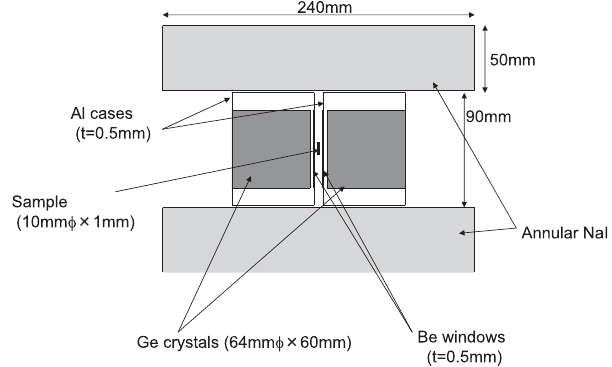
FIG. 2. A schematic view of a low-background (cid:1) detection system with two Ge detectors and a cylindrical NaI active